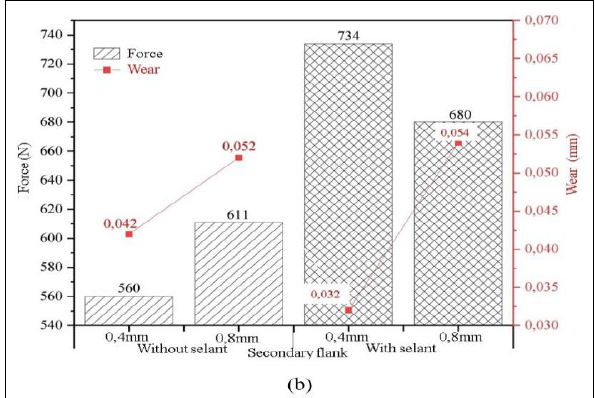
Figure 10b: Machining forces x wear: (b) Secondary flank. Source: Authors, (2022).